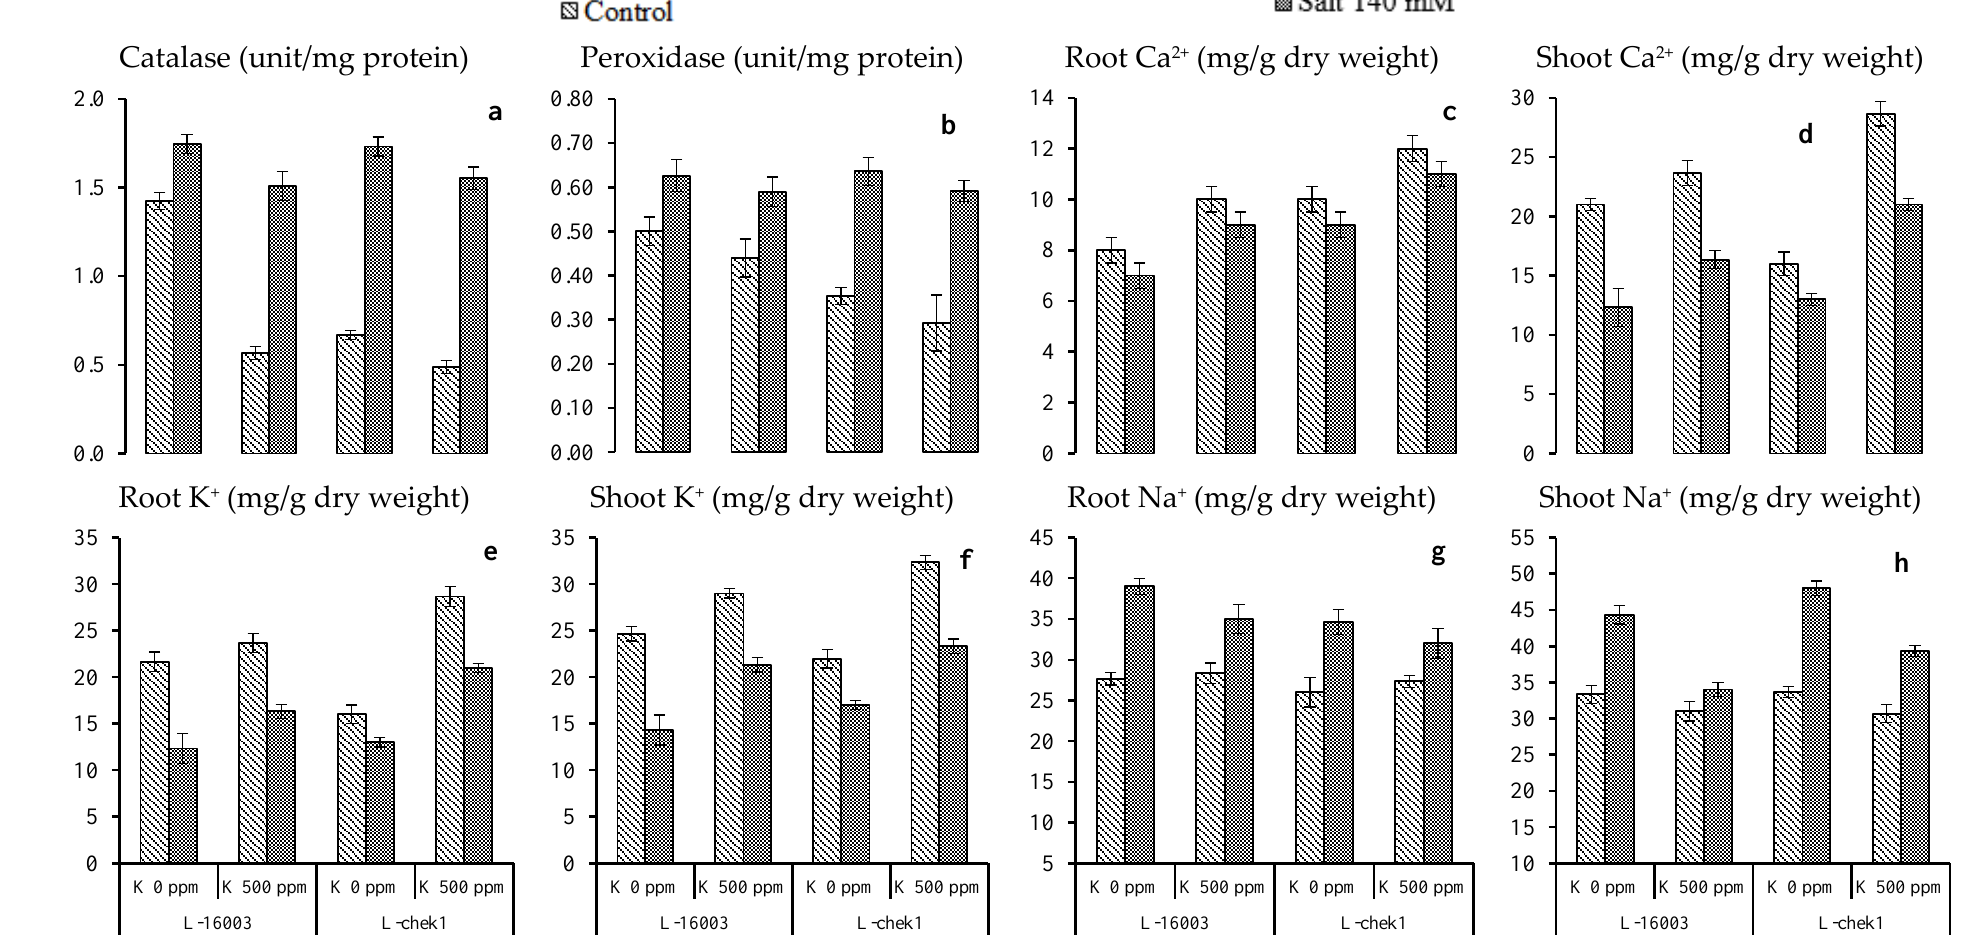
Figure 3. Impact of foliar applied potassium on the catalase ( a ), peroxidase ( b ) activities, root Ca 2+ ( c ), shoot Ca 2+ ( d ), root K + ( e ), shoot K + ( f ), root Na + ( g ), and shoot Na + ( h ) of sunflower hybrids grown under a salinity stress environment.